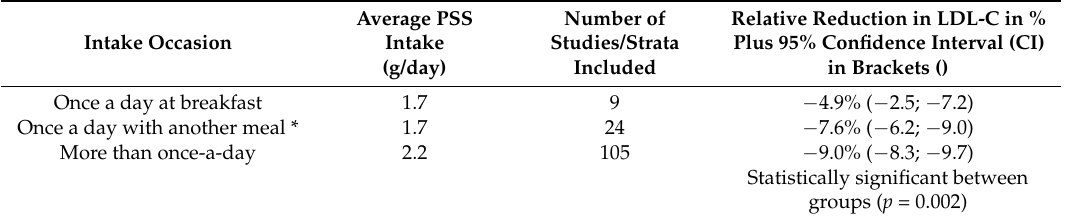
Table 3. Impact of intake occasion (i.e., with a meal) plus intake frequency on the LDL-cholesterol (LDL-C) lowering effect of plant sterols and stanols (combined as PSS) based on meta-analysis data #